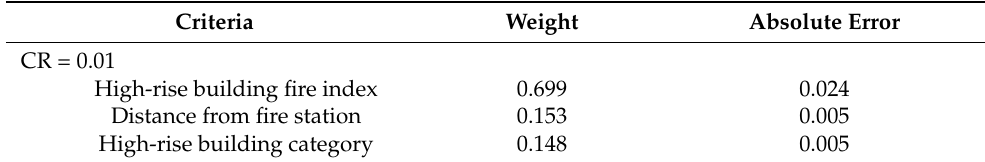
Table 6. HRBFI response